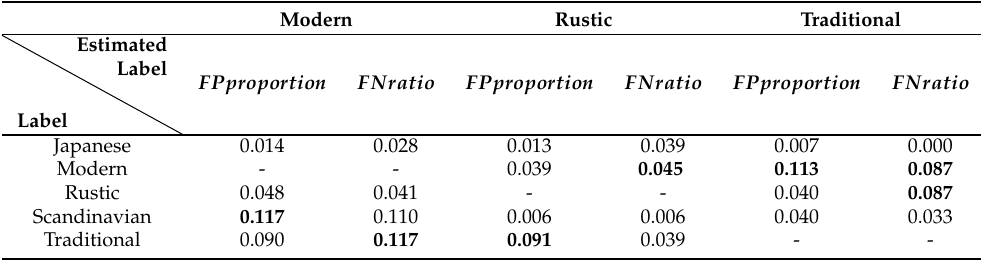
Table 5. FPproportion and FNratio for ResNet.